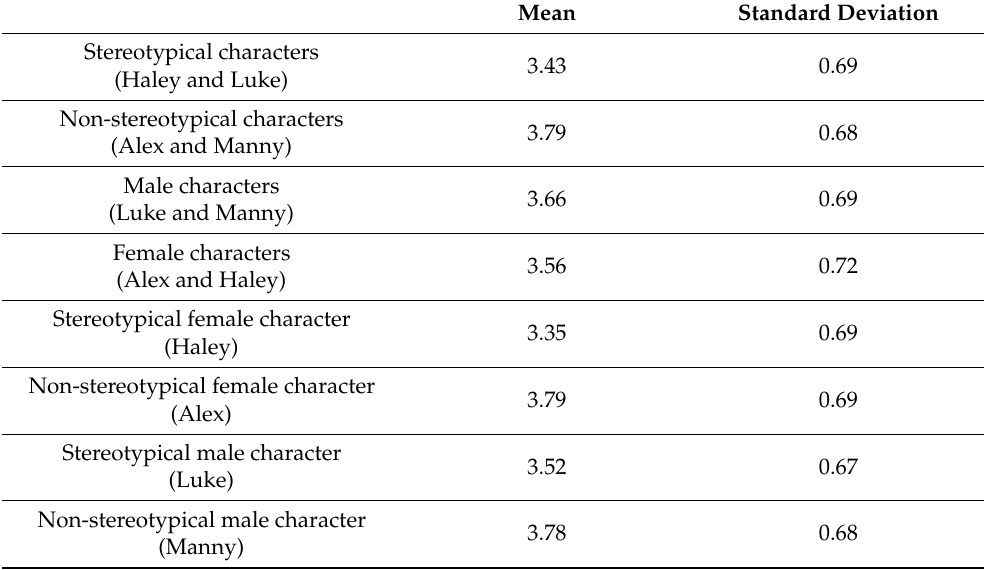
Table 3. Means and standard deviations of parasocial friendship with various character groups.